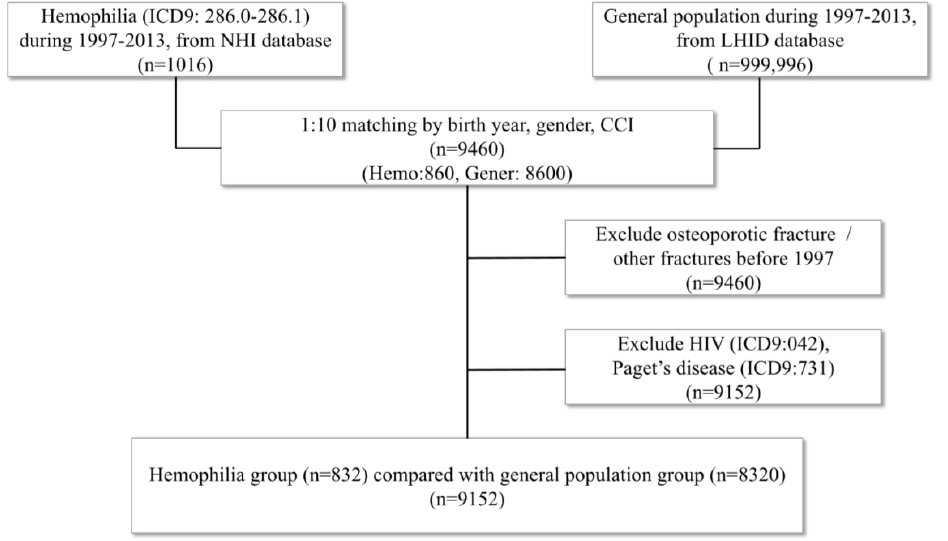
first fracture. Y3 means osteoporotic fracture. † Adjusted for Hypertension, Chronic kidney disease